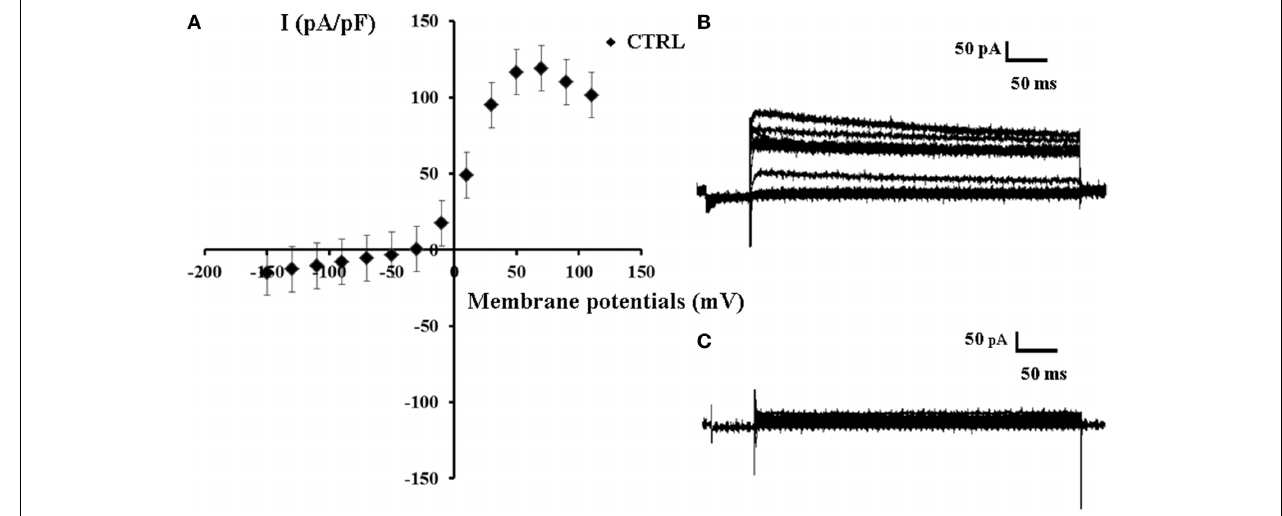
HP = − 60mV (Vm), using whole-cell patch-clamp technique. The K + -current was leak subtracted and normalized to capacitance. The intercept of the I/V curve on the voltage membrane axis was − 33mV. (B) Sample traces of the K + ions current recorded in the control conditions. (C) Sample trace of the leak current recorded in asymmetrical K + ion concentrations in the presence of Ba 2 + ions (5 × 10 − 3 M) and TEA (5 × 10 − 3 M) in the bath